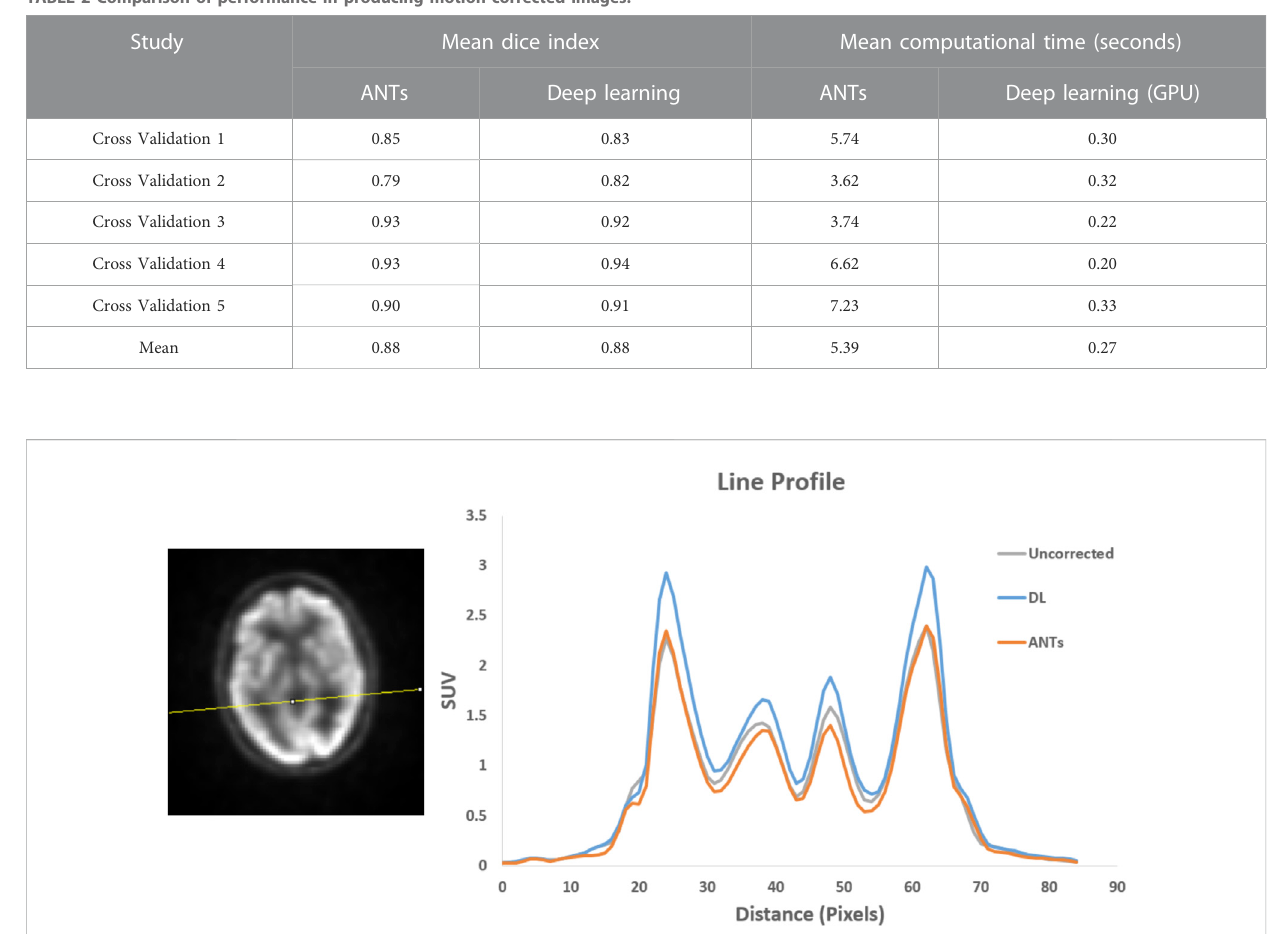
FIGURE 7 Patient Study 1: A region in the brain area (left) where a line pro fi le (right) was manually drawn. The peak-to-valley ratio for the motion-corrected data with the deep learning (DL) approach is shown to be higher than the ANTs